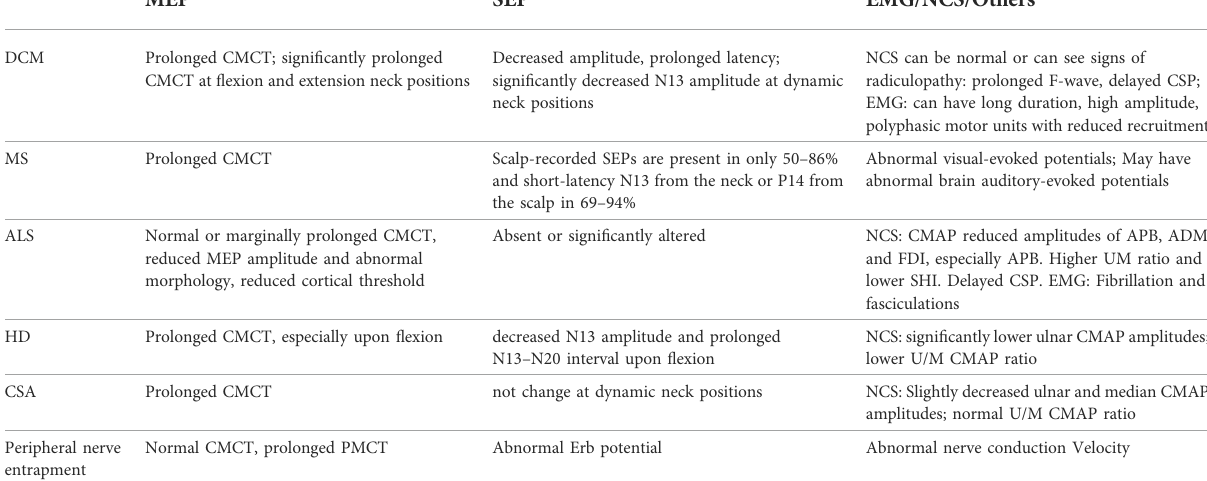
TABLE 2 Differential